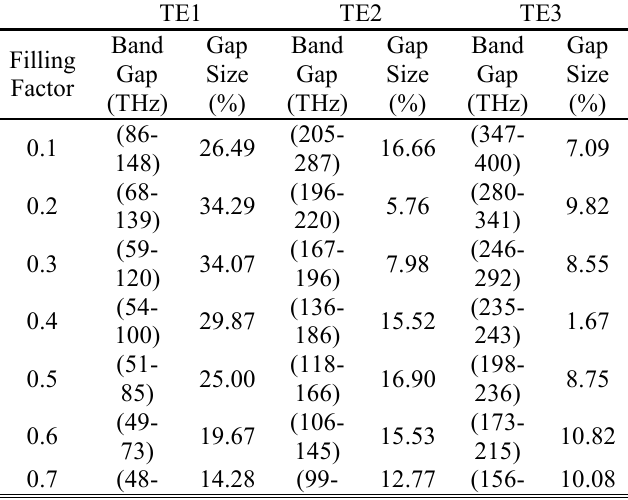
Table 1: Variation of full band gap size for TE modes with filling factor for BiTeCl based layers in air background.